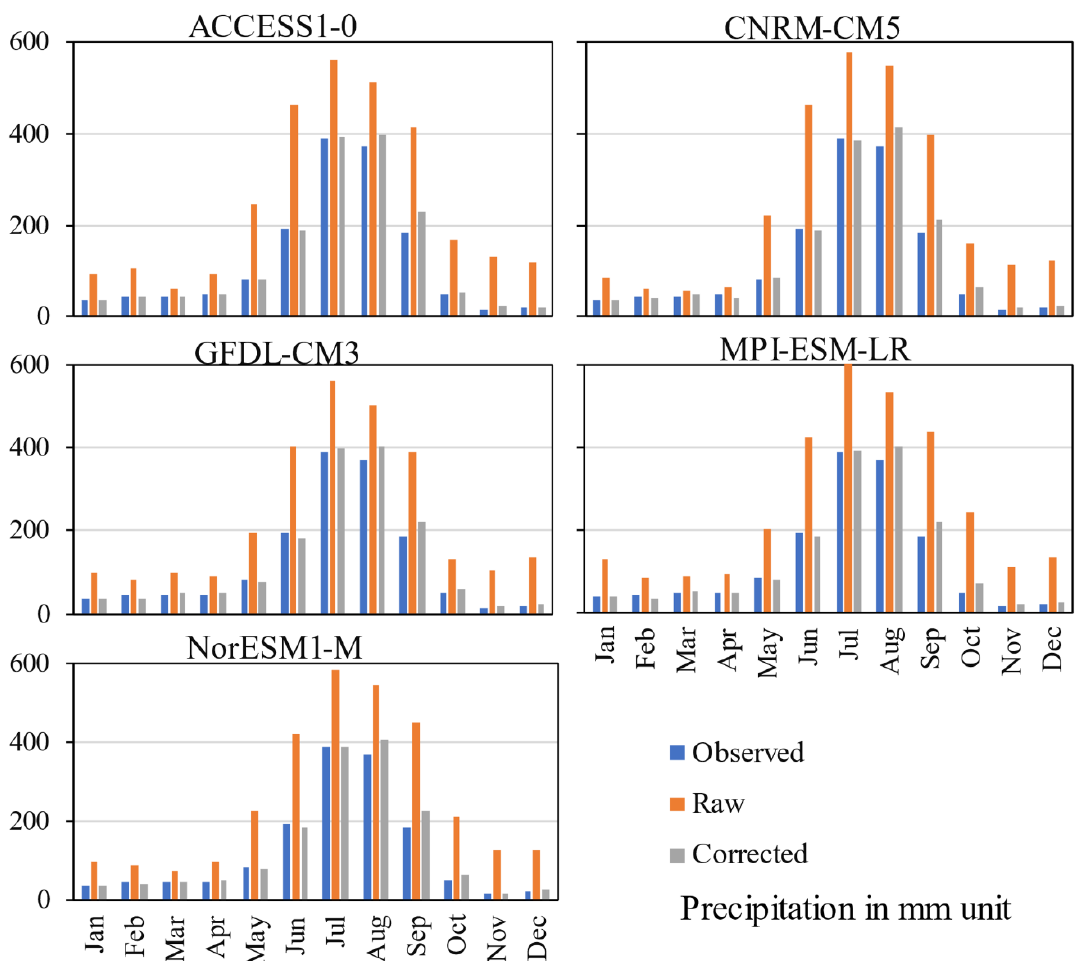
Figure 2. The performance of climate models before and after bias correction is taken as an ensemble monthly average for observed and climate model data. The blue bar represents the observed data, the orange bar represents the uncorrected historical climate model data, and the grey bar represents the corrected historical climate model data. Table 2. The statistical performance of different climate models at various stations before and after application of bias correction. ‘Raw’ represents the statistical performance of the climate model before bias correction, while BC represents after bias correction.